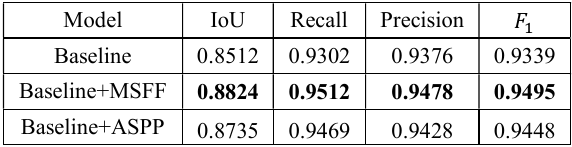
Table 3. Accuracy statistics of ablation experiments of MSFF